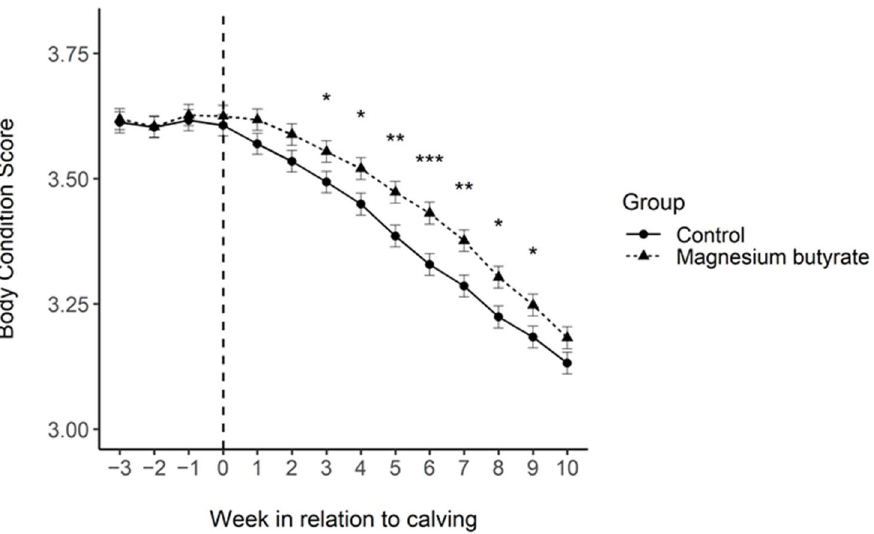
Figure 2. The evolution of BCS in cows of Control (●, n = 112) and Magnesium butyrate ( ▲ , n = 107) groups from −3 to 10 weeks in relation to calving. Statistical significance is based on pairwise comparisons after fitting a linear mixed effects model. Results are presented as estimated marginal means (±SEM); * p < 0.05; ** p < 0.01; *** p < 0.001. Further details of the milk yield and BCS are provided in Supplementary File